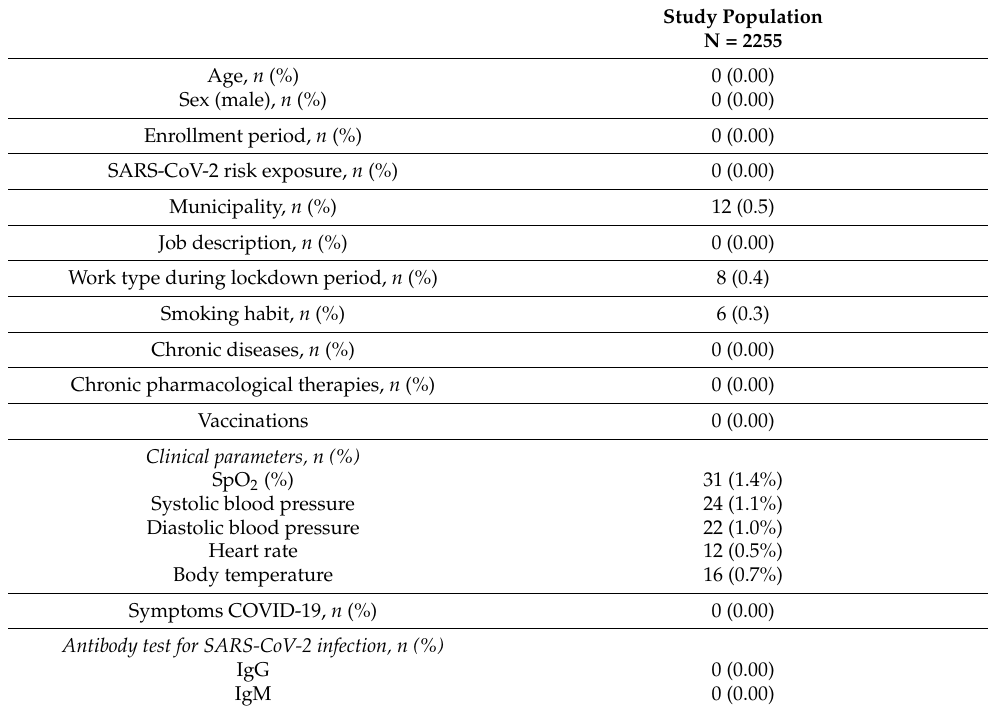
Table A1. Missing data in the study